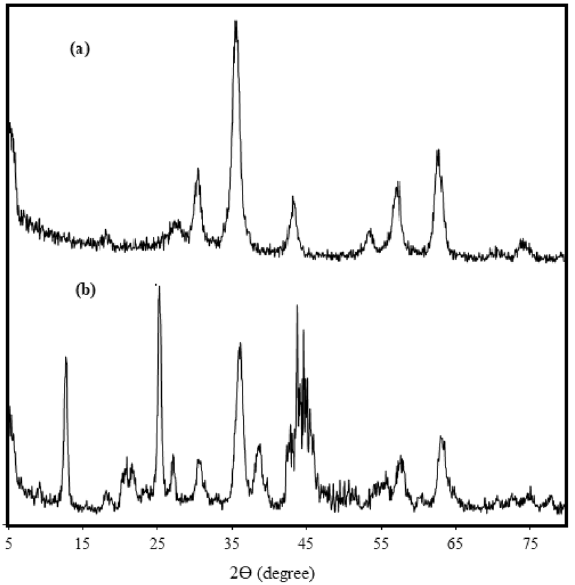
Figure 2. XRD patterns of ( a ) Fe3O4, and ( b ) HS-Alginate-Ag/Fe 3 O 4 nanocomposite.